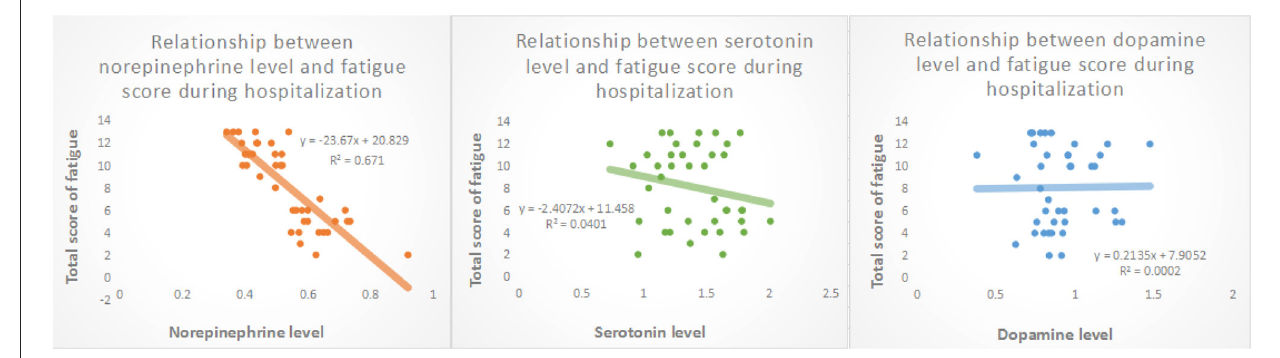
FIGURE 2 | Relationship between levels of biological transmitters in peripheral venous blood and fatigue scores during hospitalization.